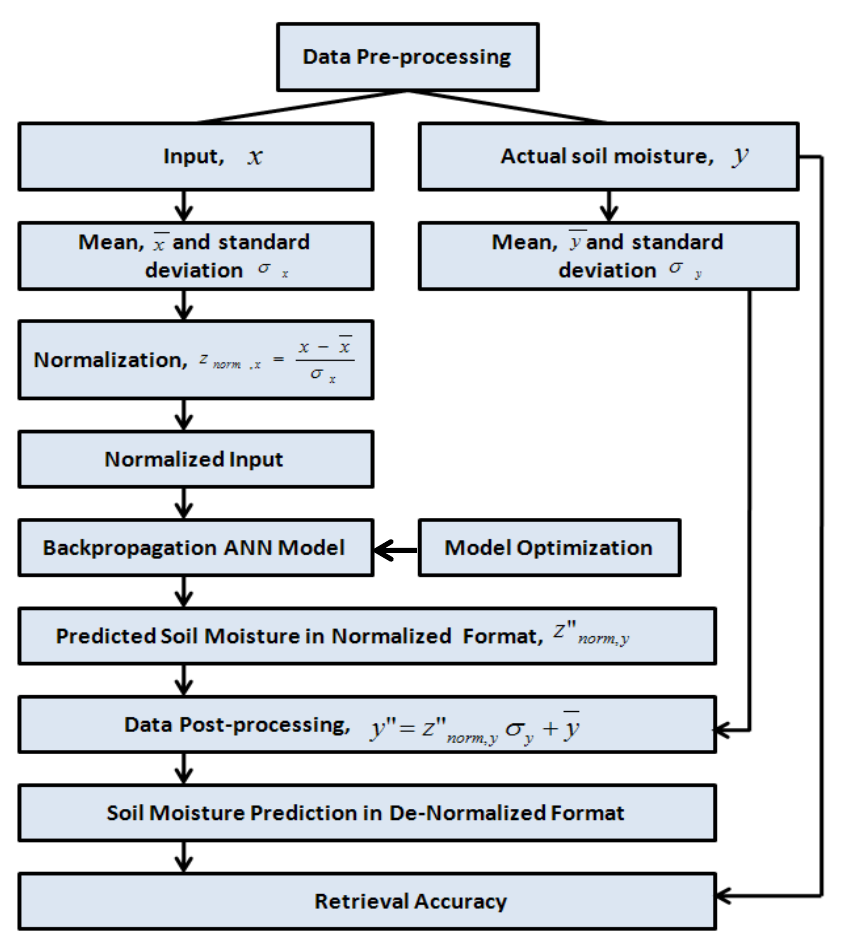
Figure 2. The pre- and post-processing of the